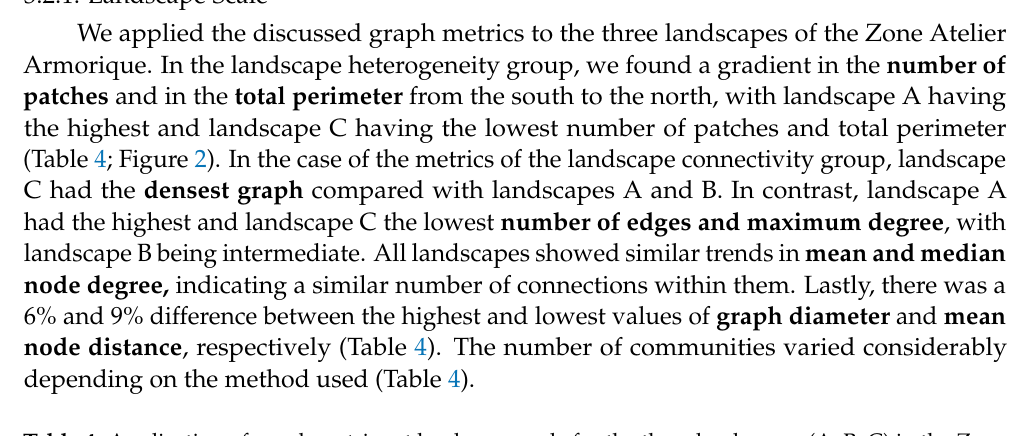
Table 4. Application of graph metrics at landscape scale for the three landscapes (A, B, C) in the Zone Atelier Armorique in